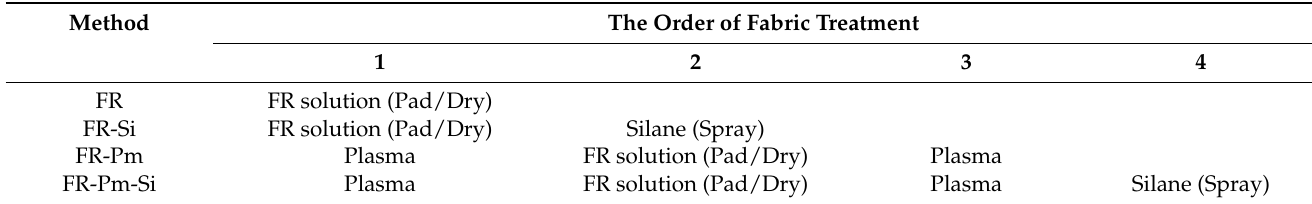
Table 2. Sample preparation methods of FR treated Flax/PP and Flax/PLA fabrics.